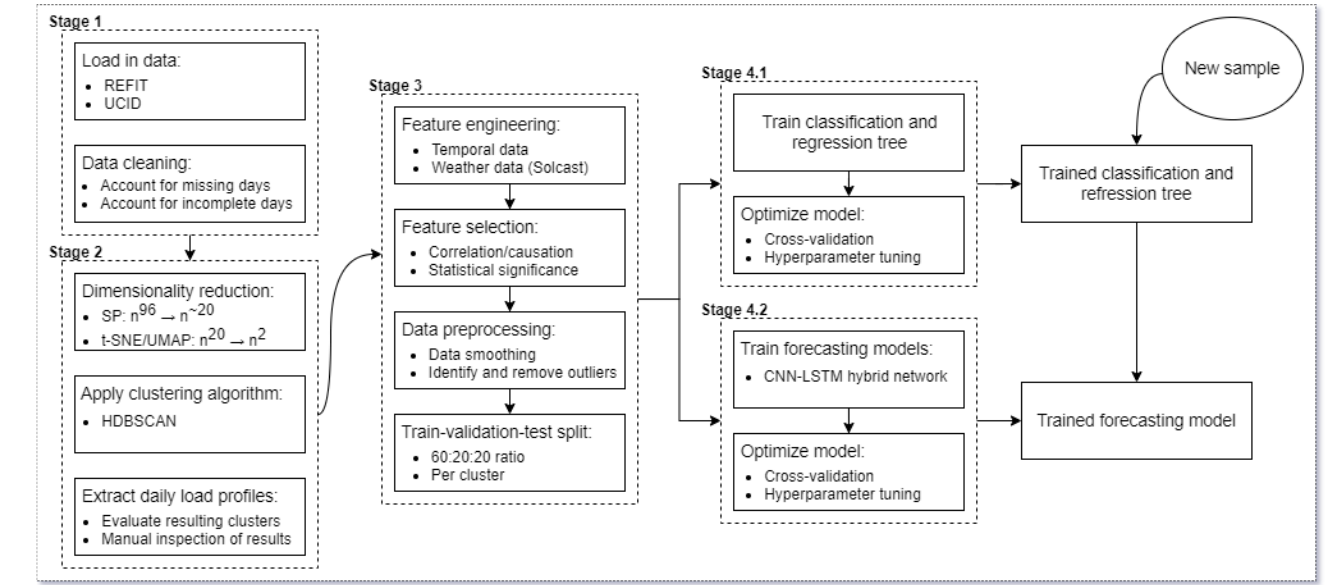
Figure 2. Proposed daily profile extraction and load forecasting